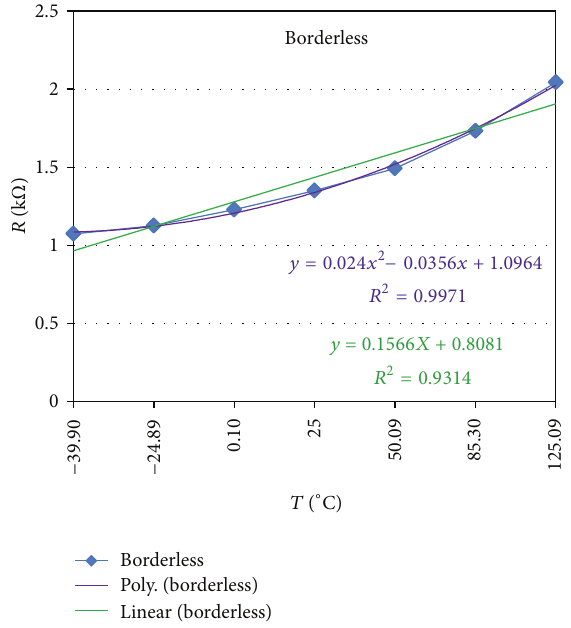
Figure 2: The measured input resistance versus temperature for borderless